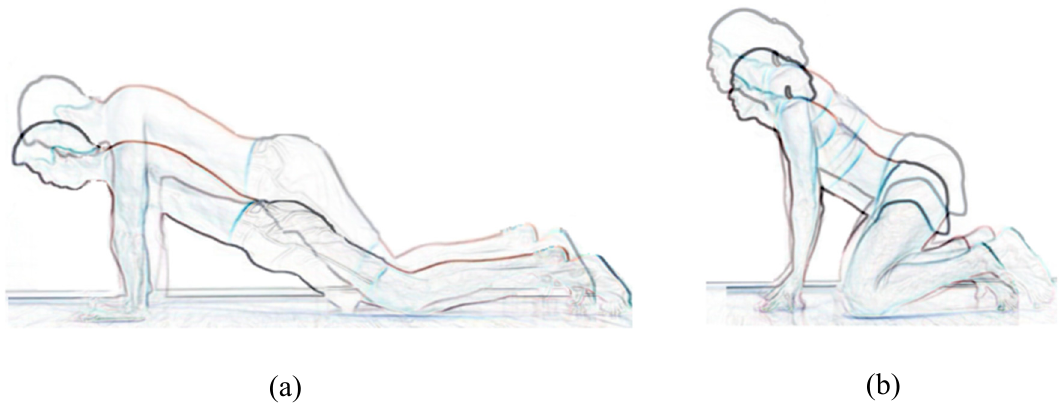
Figure 2. ( a ) Missionary posture. ( b ) Cowgirl posture.